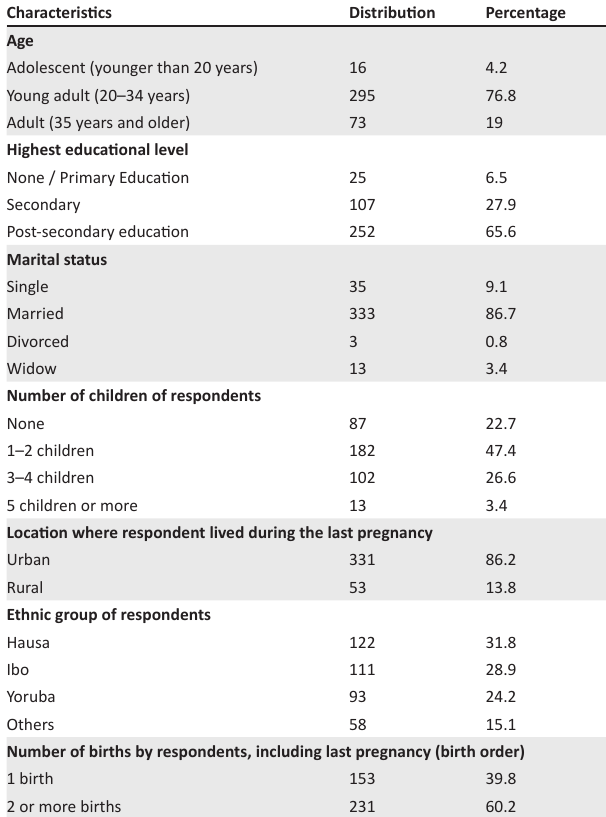
TABLE 3: Socio-demographic characteristics of the respondents ( N =